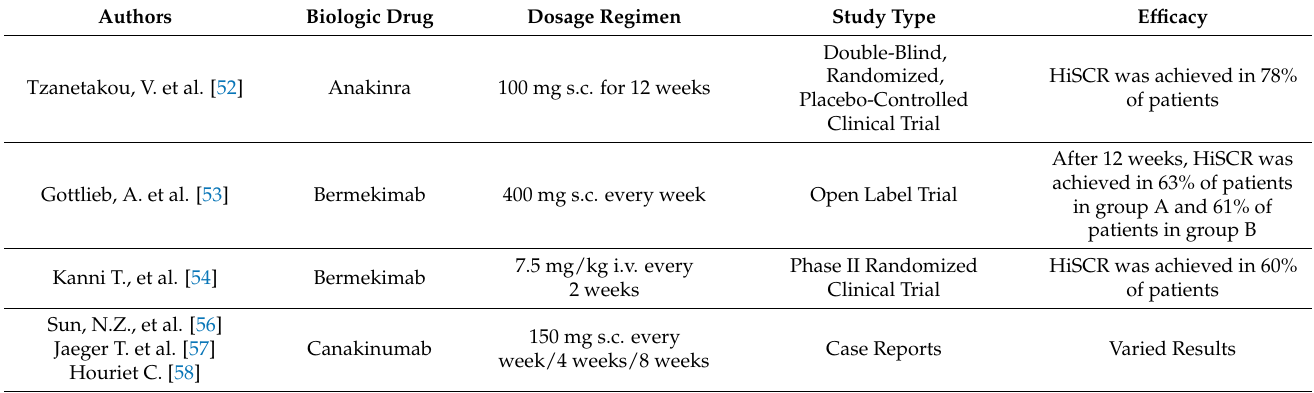
Table 1. A summary of significant clinical studies concerning the IL-1 inhibitors in